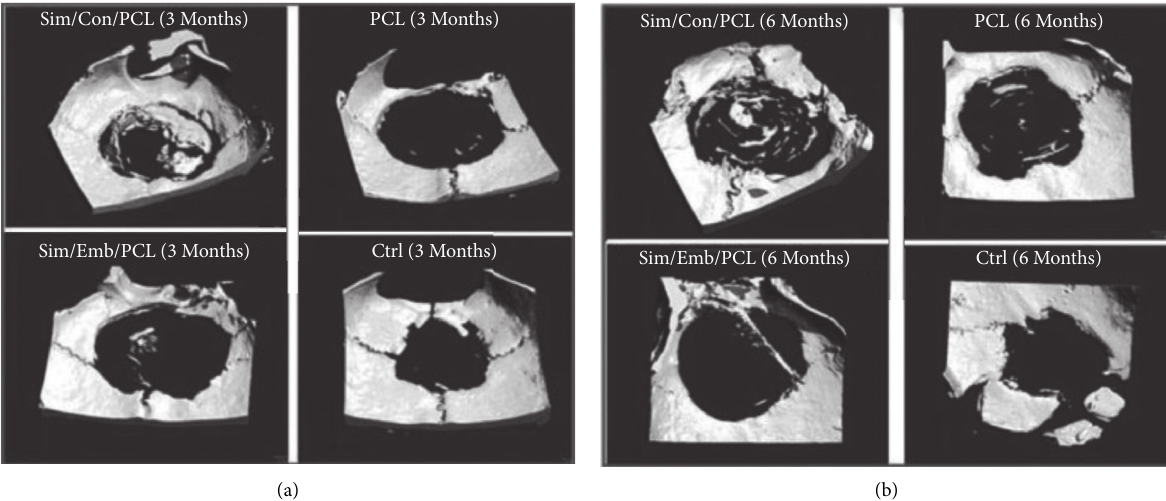
Figure 2: Micro-CT 3D images representing whole sample: ‘‘simvastatin-containing PCL scaffolds’’; PCL scaffold without simvastatin; ‘‘simvastatin-embedded PCL scaffolds’’; and critical size defect without any scaffold (control group). (a) 3 months and (b) 6 months; reproduced with permission from [36].